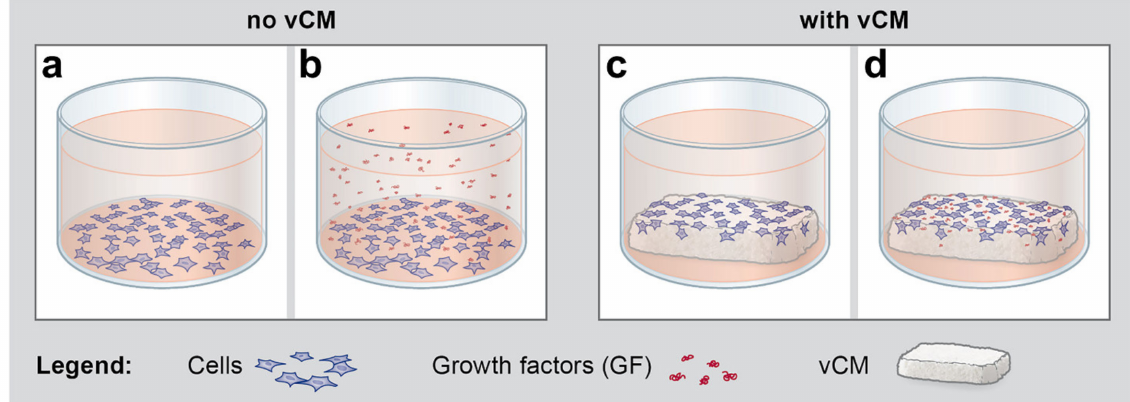
Figure 3. Schematic representation of the conditions under which hPDLCs, hOFs, and HUVECs were seeded for subsequent qRT-PCR analyses of the anti- and pro- fibrinolytic gene expression presented in Figure 4, Figure 5, and Figure 6. ( a ) Starved cells were grown for 48 h on tissue culture plastic in the absence of vCM and growth factors (GF), a condition further denoted as a control (Ctrl). ( b ) Starved cells were grown for 48 h on tissue culture plastic in the presence of GF applied in suspension. ( c ) Starved cells were grown for 48 h on native/uncoated vCM placed in ultra-low attachment plates. ( d ) Starved cells were grown for 48 h on vCM coated with EMD or each of the four recombinant growth factors, TGF- β 1, PDGF-BB, FGF-2, or GDF-5 in ultra-low attachment plates. Please note that the scheme illustrates the conditions upon cell seeding and therefore, released from the vCM growth factors are not depicted in the cell culture medium in ( d ). In addition, there is no obvious difference in the appearance between tissue culture-treated plates for adhesive culture ( a,b ) and ultra-low attachment plates ( c,d